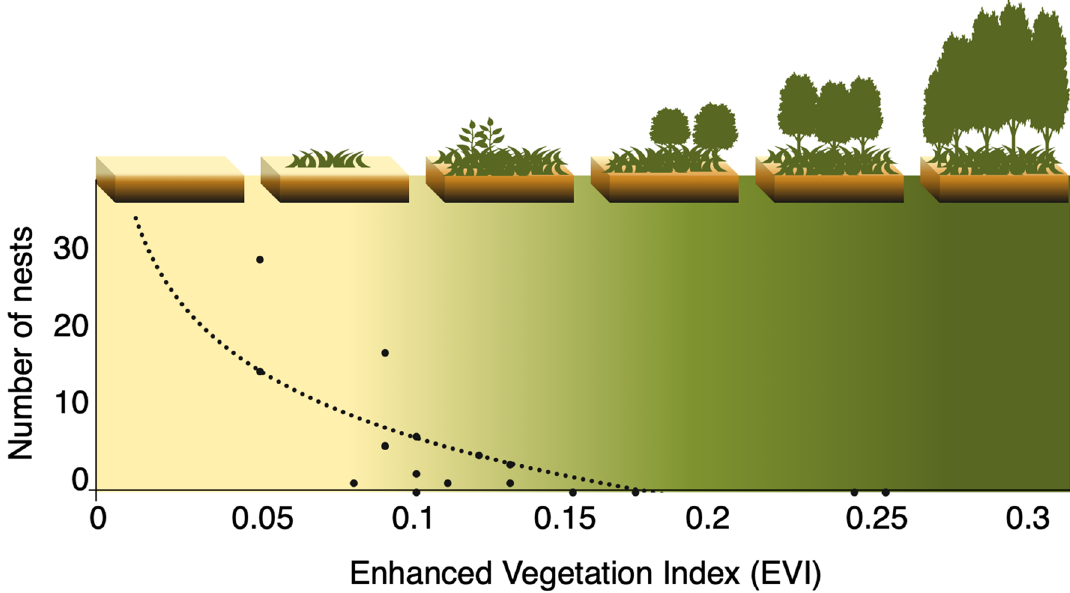
Figure 4. The relation between EVI and number of gharial nests in the study area. It revealed that nesting number decreased with increasing EVI. Gharial nests occur in a narrow habitat in between the river water (EVI < 0, brown shade) and woody vegetation (EVI > 0.13, green